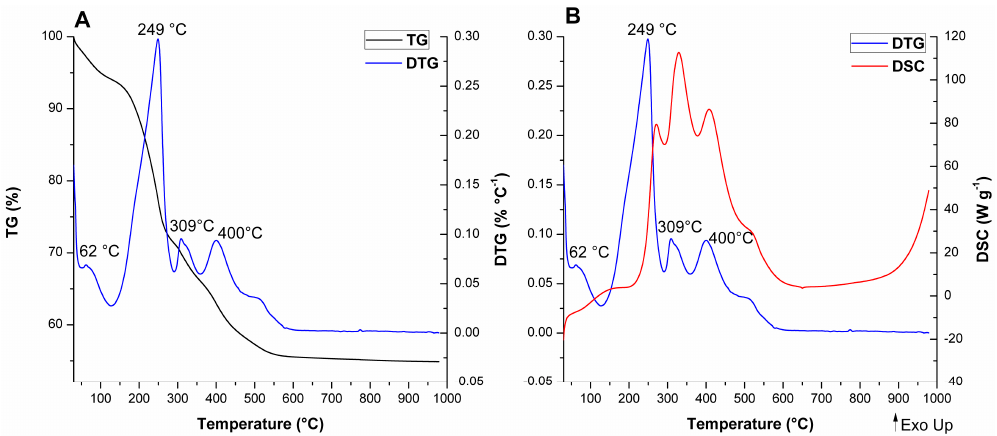
Figure 13. Thermal analysis obtained under synthetic air for A-Ce-MCM-NO 3 : TG and DTG curves ( A ); DTG and DSC curves ( B ). The temperatures indicated refers to DTG maximums of observable peaks.